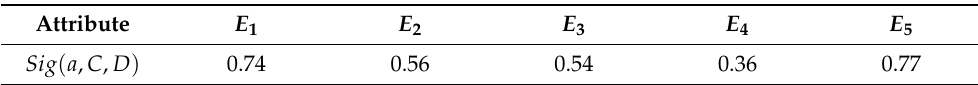
Table 3. Description of attribute